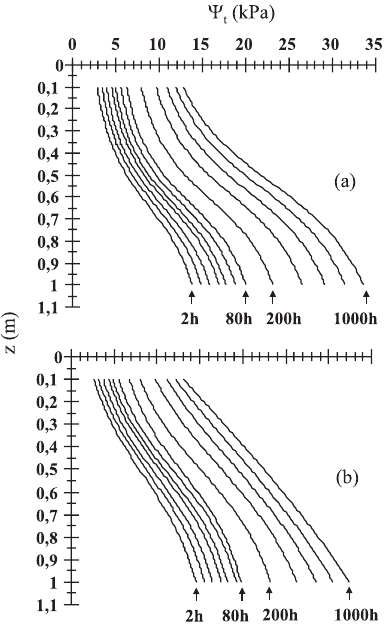
Figura 4. Evolução do valor absoluto de potencial total com a profundidade nos diferentes tempos de redistribuição na bateria de tensiômetros da esquerda (a) e da direita (b).